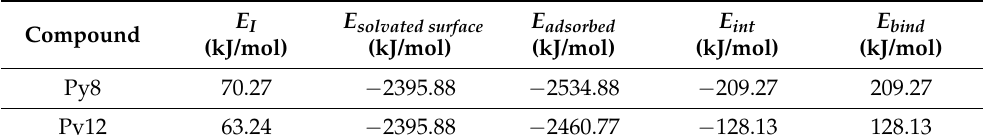
Table 10. Interaction energy ( E int ) and binding energy ( E bind ) values calculated for the inhibitors and solvated Fe surface using molecular mechanics (MM+).